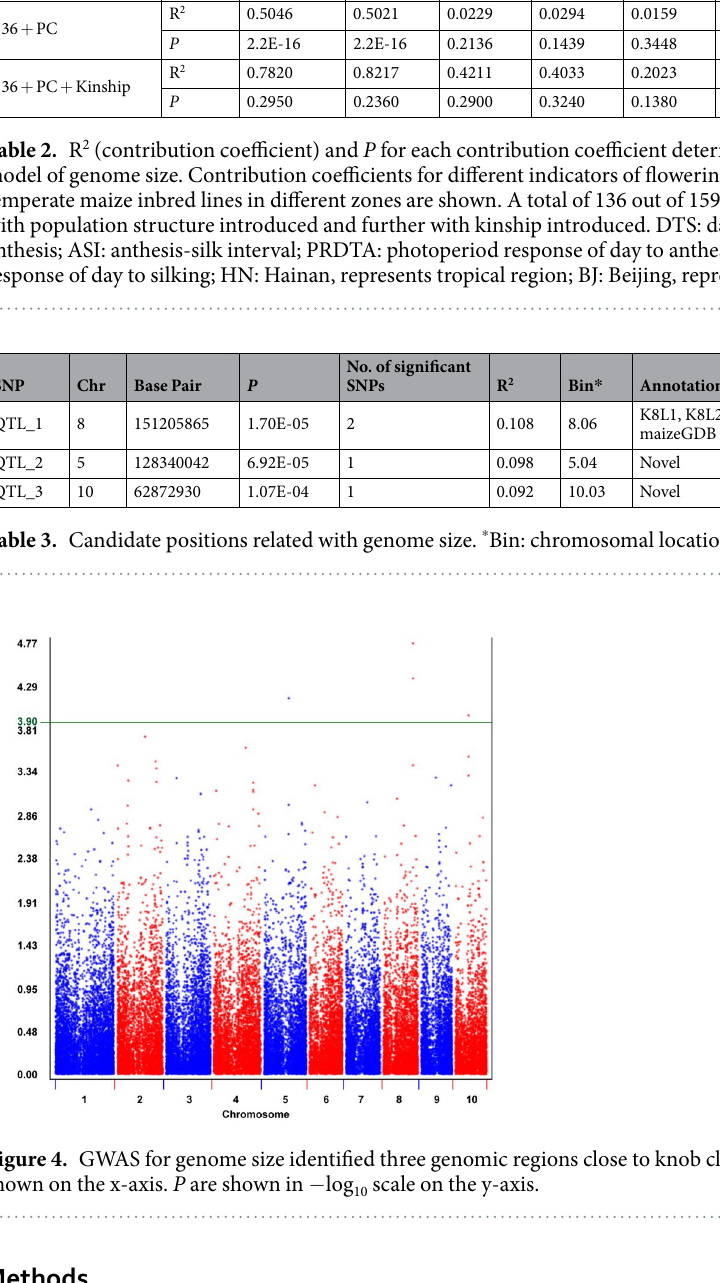
Quantification of maize genomic DNA.